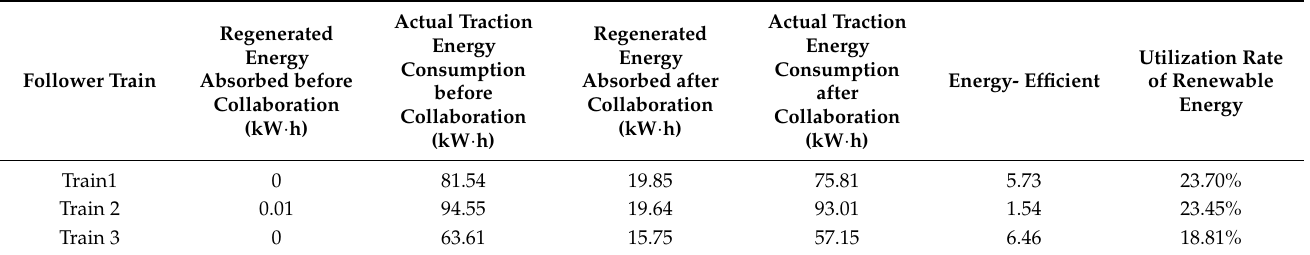
Table 5. Train punctuality.